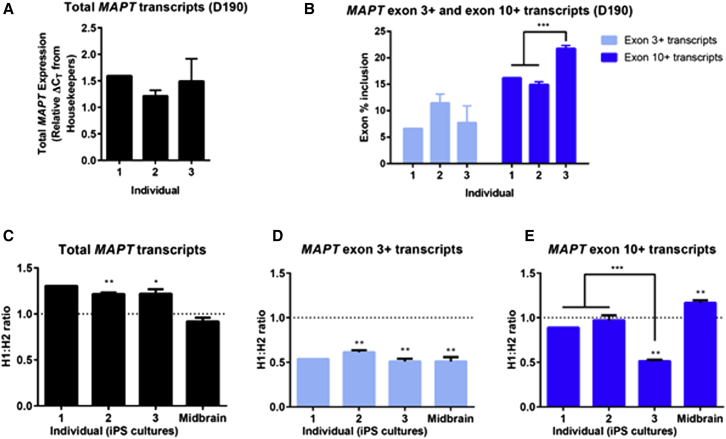
Dopaminergic Neuronal Cultures Exhibit Significant Differences in Isoform Expression from H1 and H2 Alleles at 6 MonthsTaqMan-based real-time qPCR expression assays on samples at DIV190. Mean ± SEM; individual 1, n = 1 clone; individuals 2 and 3, n = 3 clones; ≥3 cDNA samples per clone.(A) Total MAPT expression reported as relative ΔCT of geometric mean of three housekeeper genes (GAPDH, HPRT1, and ACTB). n.s., not significant, one-way ANOVA.(B) Percent inclusion of alternatively spliced exons 3 (light blue) and 10 (dark blue) at DIV190. The three individuals show similar inclusion of exon 3, whereas individual 3 shows a significantly greater inclusion of exon 10. Significant difference between groups in an unpaired t test: ∗∗∗p = 0.0005.(C–E) Allele-specific expression assays distinguishing transcripts of H1 and H2 allelic origin, presented as H1:H2 ratio, i.e., values >1 show higher H1 expression. Data from analysis of human midbrain (C) n = 9; (D) n = 5; and (E) n = 9. (C) Individuals 2 and 3 show significantly greater expression of total MAPT transcripts from the H1 chromosome (individual 2, ∗∗p = 0.0059; individual 3, ∗p = 0.0471; midbrain, n.s.). (D and E) The H1:H2 ratio is normalized to the H1:H2 ratio of total MAPT transcripts per sample. ∗Significant difference from mean of 1 in a one-sample t test. (D) There are 2-fold greater exon 3-containing transcripts coming from the H2 chromosome. Individual 2, ∗∗p = 0.0032; individual 3, ∗∗p = 0.0040; midbrain, ∗∗p = 0.0020. (E) Haplotype-specific expression of exon 10 varies between individuals and midbrain: Individual 2, n.s.; individual 3, ∗∗∗p = 0.0008; midbrain, ∗∗p = 0.0005. Significant difference between groups in an unpaired t test: ∗∗∗p = 0.0005. See also Figures S3 and S4.